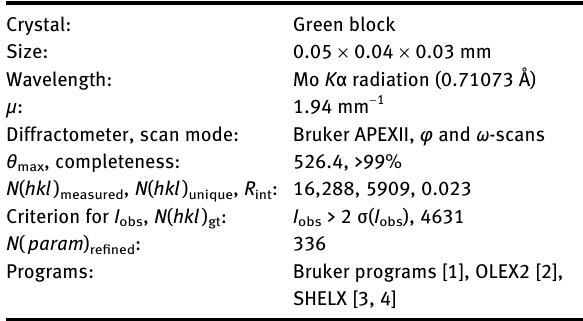
Table 1 contains crystallographic data and Table 2 contains the list of the atoms including atomic coordinates and displacement parameters.